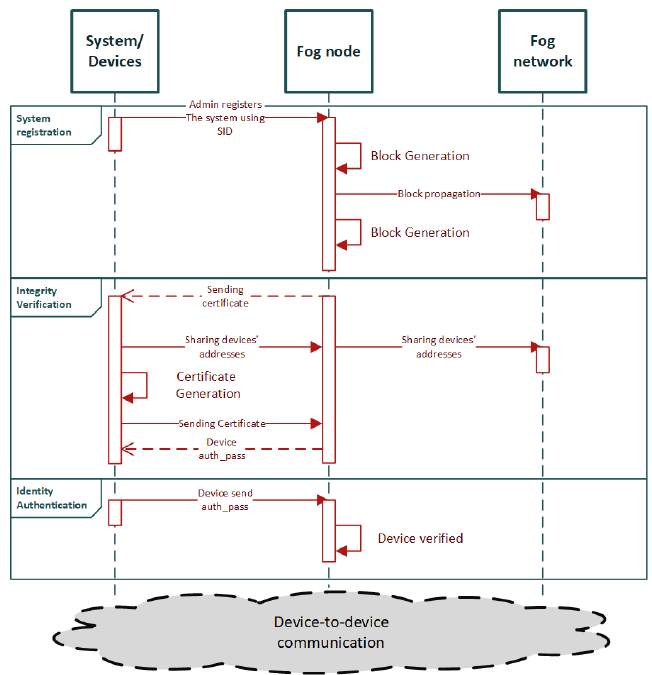
Figure 5. Sequence diagram of the proposed scheme in [39].